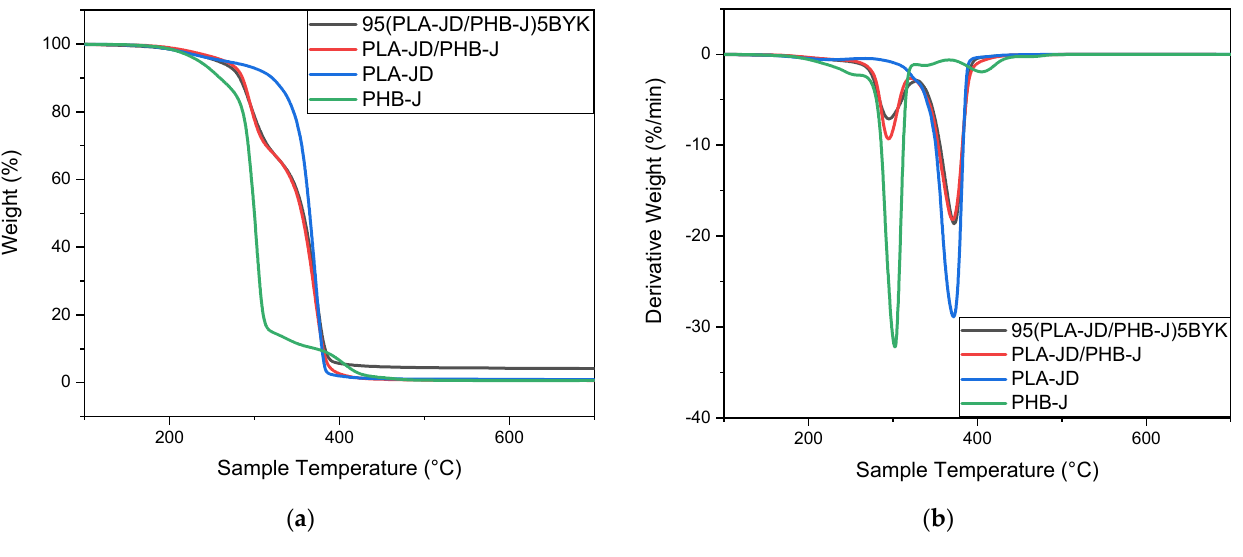
Figure 10. ( a ) TGA and ( b ) derivative thermogravimetric analyses of PLA-JD, PHB-J, PLA-JD/PHB-J, and 95(PLA-JD/PHB-J)5BYK blends.